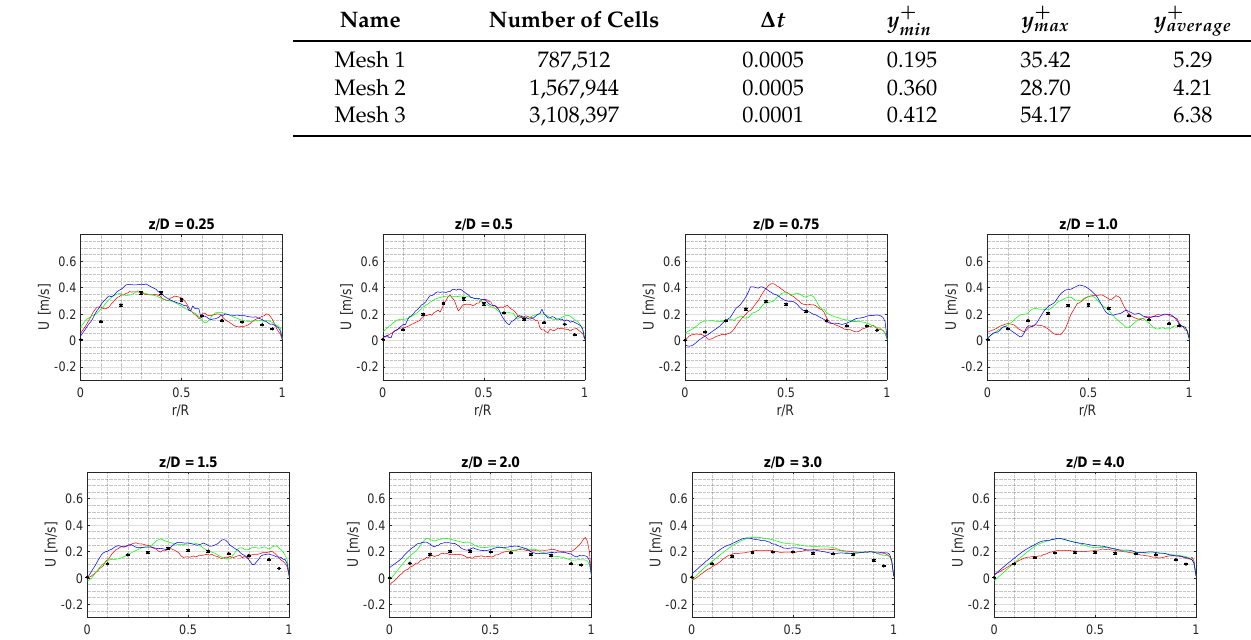
Table 3. Details of the numerical grids for sudden expansion test case.